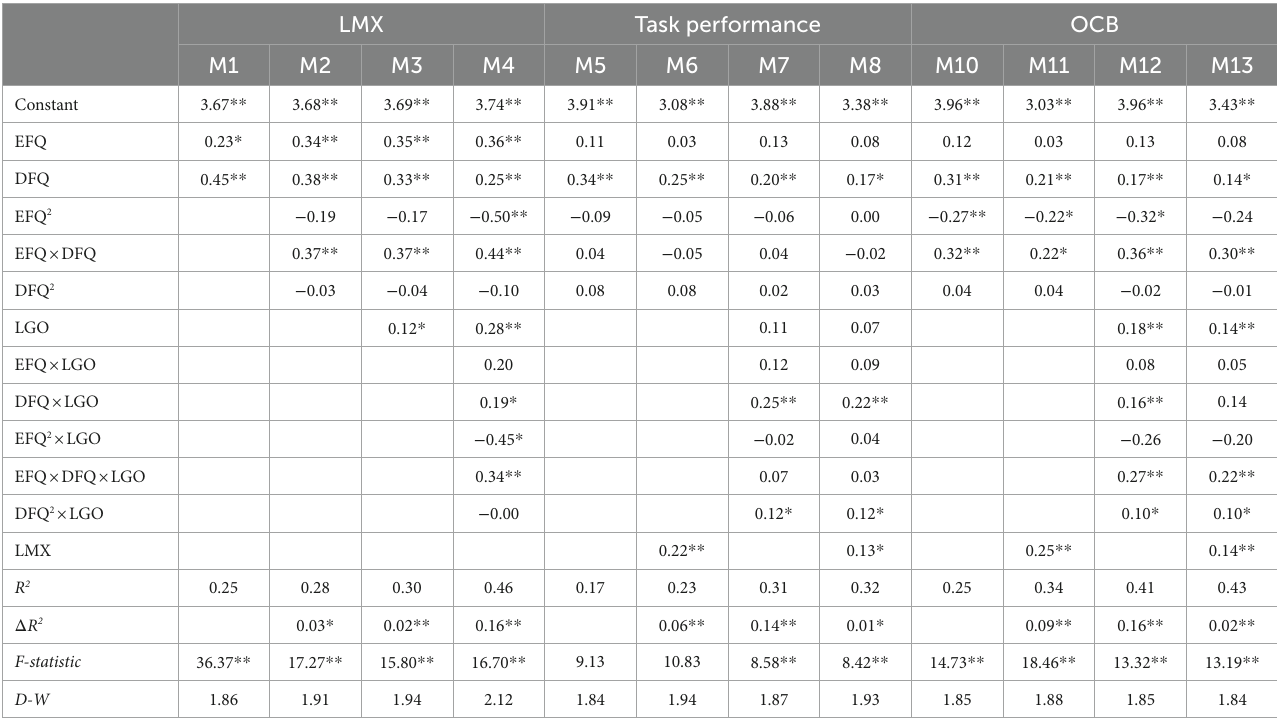
TABLE 3 The polynomial regression analyses results.